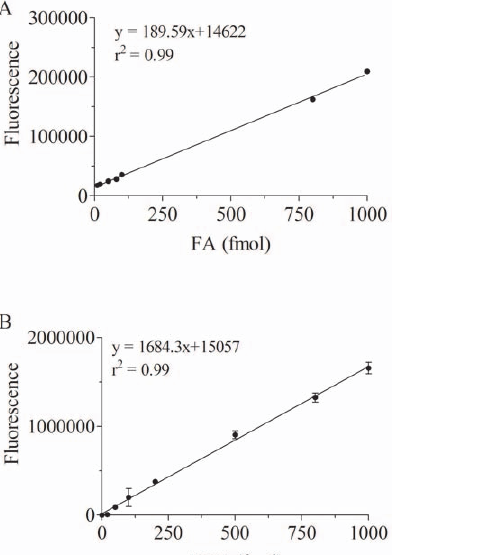
Figure 6. Relationship between FA and JH III concentrations after derivatization and fluorescence intensities. A) FA. B) JH III. Data represent the means 6 SD of three independent experiments.